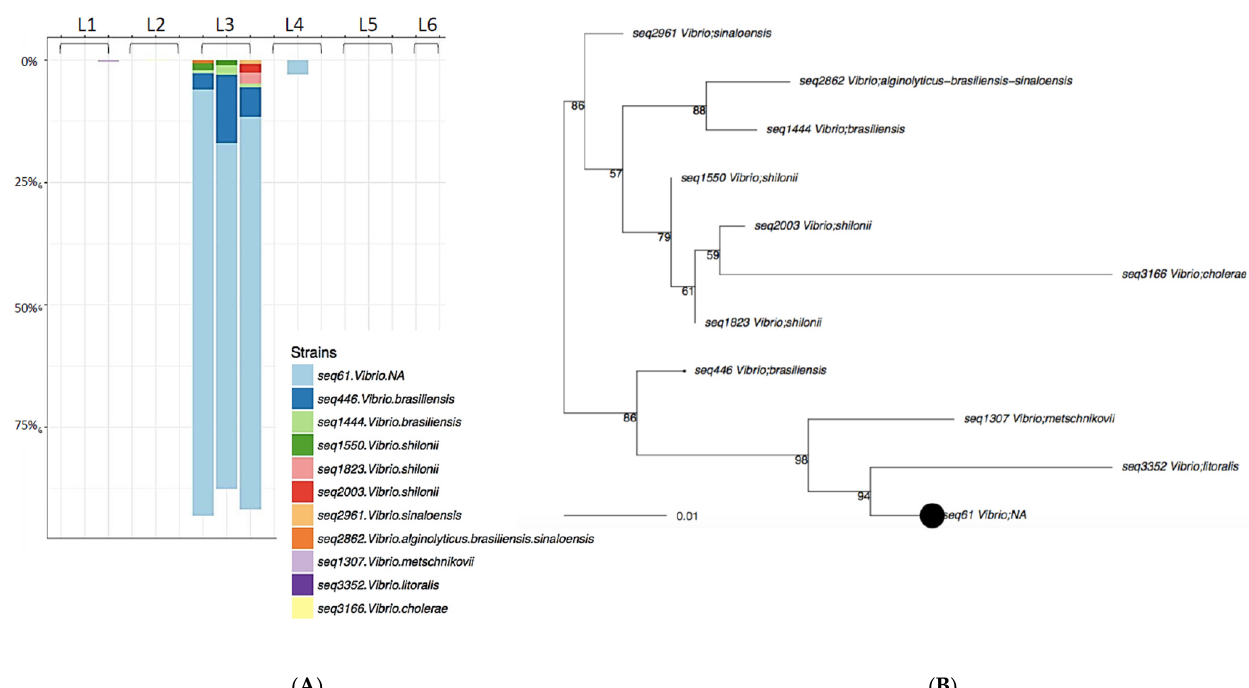
Figure 4. Laundromat L3 rRNA Taxa plot (A) and sequence diversity (B). Vibrio species were identified in high abundance on samples washed in Rockland County, NY (L3).